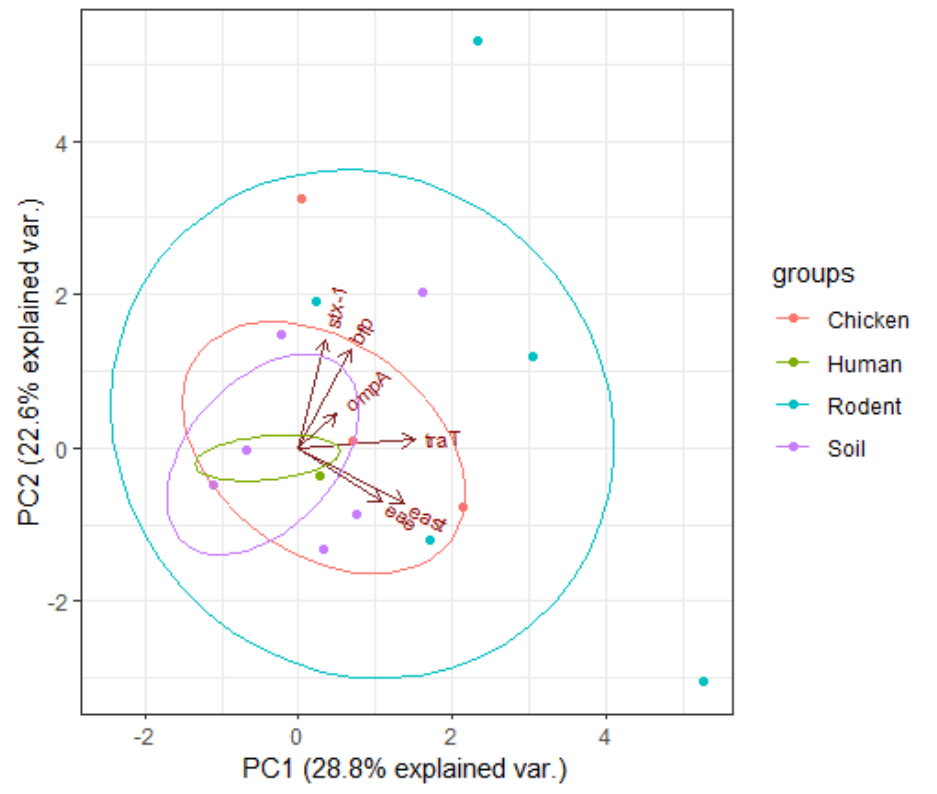
Figure 7. Principal component analysis for virulence genes of E. coli isolates. The dots represent isolates from different sources of samples, arrows indicate the original variables (virulence genes of the isolates), and ellipses indicate a region that contains 95% of all samples of a particular source.